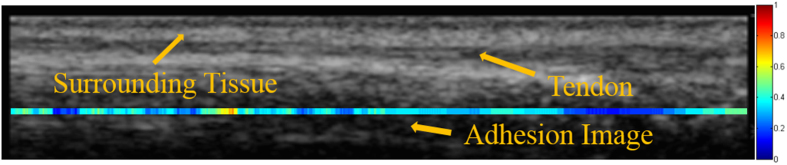
Ultrasound image of the EDC tendon and its surrounding tissue from a healthy individual.The surrounding tissue can be identified by its hyperechogenic structure while the tendon can be recognized by its less echogenic characteristics, fiber-like structure, and larger movement compared to other tissues in the region. The adhesion image indicates the locations of the tendon where the occurrence of adhesion is suspected; that is, where the relative displacement ratio is >0.6. A smaller ratio indicates a better gliding ability (relative displacement ratio of <0.6), and so the adhesion image for a healthy individual would generally appear green or blue.